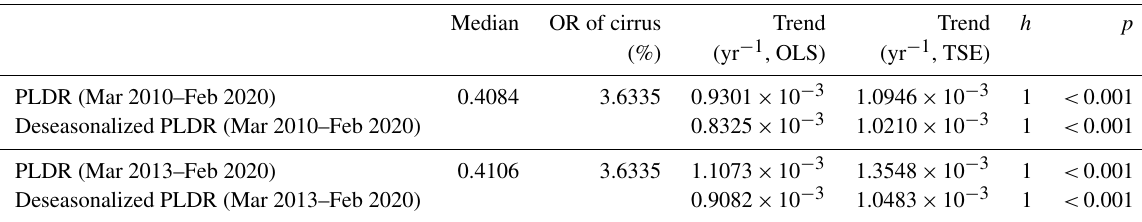
Table 2. Same as Table 1, but for the results derived from only daytime data during the period from March 2010 to February